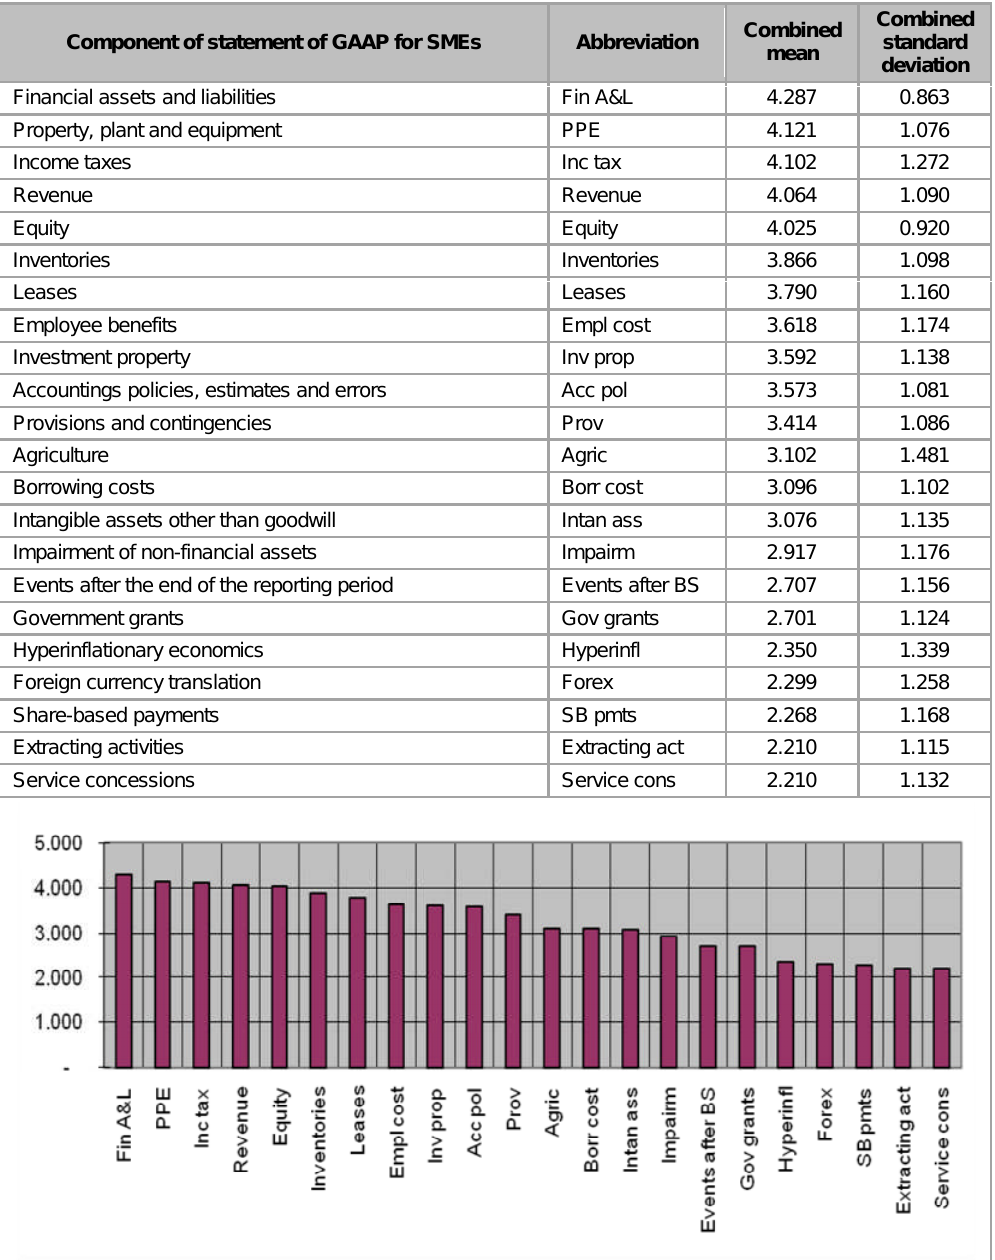
Components of IFRS for SMEs relating to specific types of